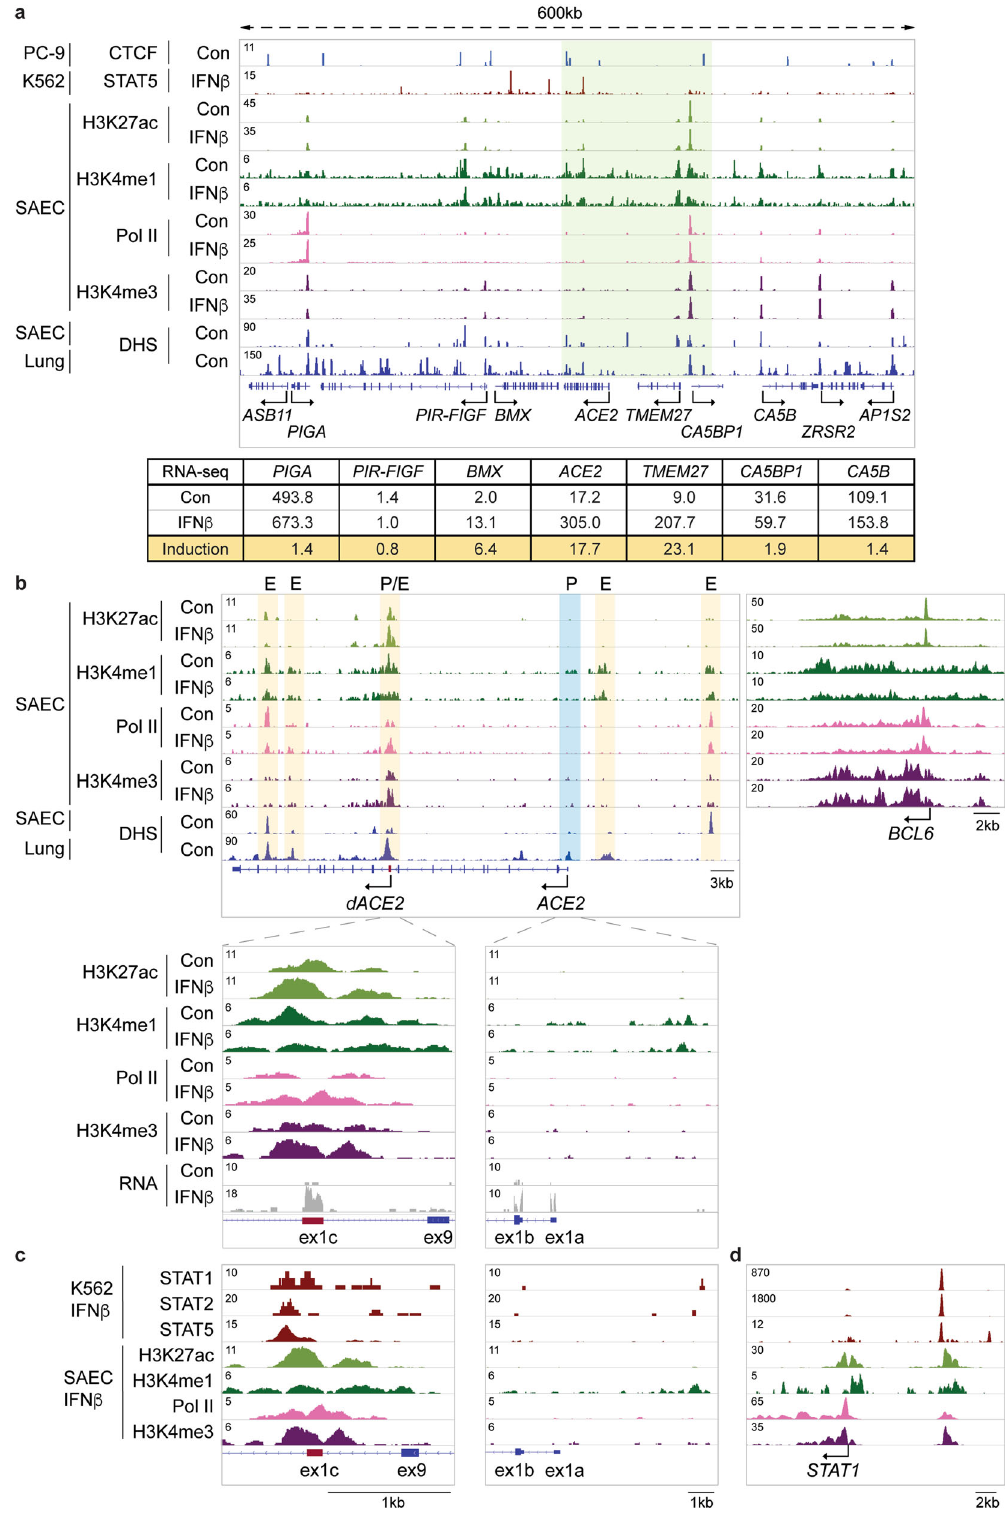
Interferons activate enhancers in the ACE2 locus . To identify candidate regulatory elements controlling the extended ACE2 locus, including ACE2 and dACE2 , in primary airway cells, we conducted ChIP-seq for the histone marks H3K27ac (activate loci), H3K4me1 (enhancers), and H3K4me3 (promoters). We also probed RNA Polymerase II (Pol II) loading in SAECs in the absence and presence of IFN β (Fig. 2). DNase I